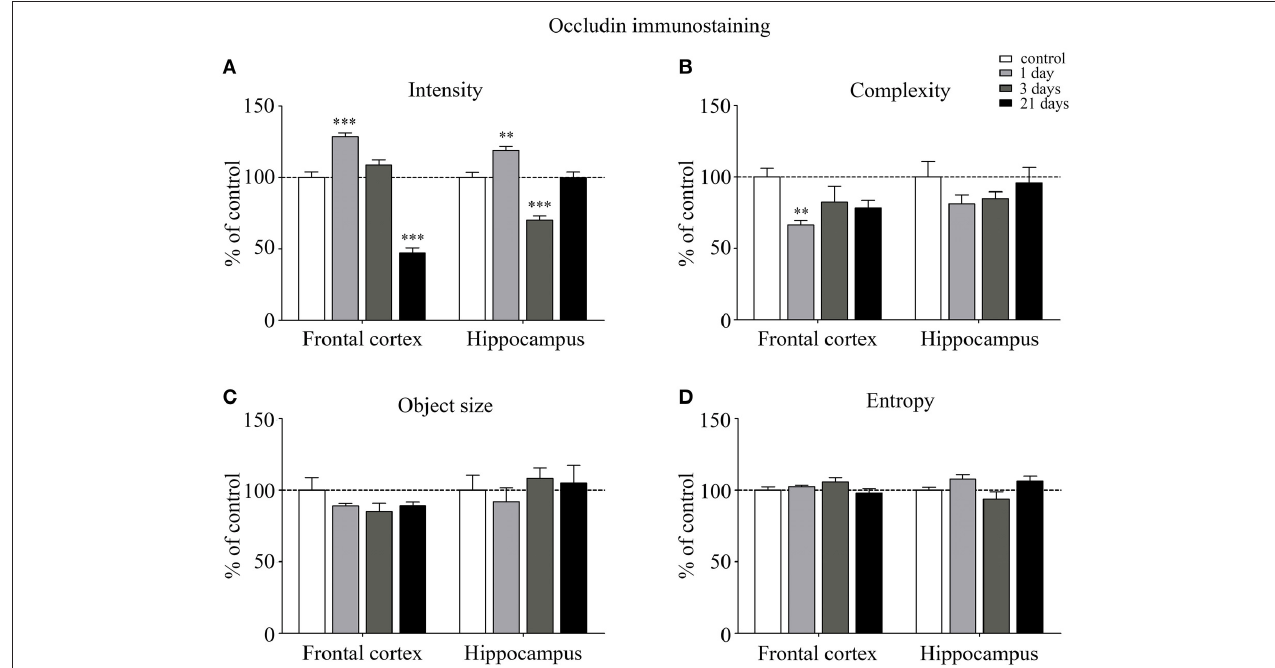
FIGURE 5 | Analysis of occludin immunofluorescence pattern in the frontal cortex and hippocampus of rats following restraint stress. Graphs represent quantification of the intensity (A) , complexity (B) , mean object size (C) and entropy (D) of immunostained samples. Results are expressed as percentages of the unstressed control group. Values for each group are means ± SEM. Data were analyzed by One-way ANOVA followed by a Bonferroni post hoc test. ** p < 0.01 , *** p < 0.001 , significant differences as compared to the unstressed control group.